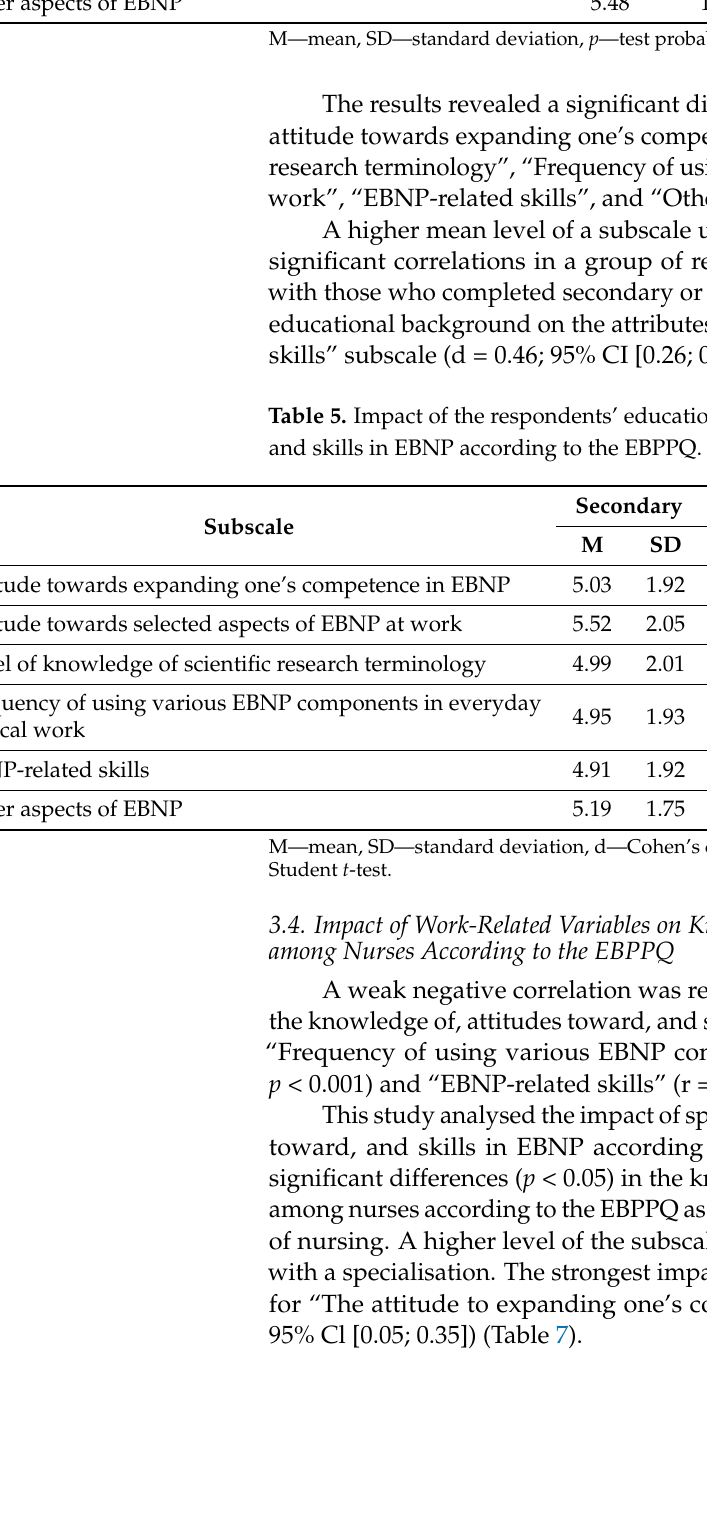
Table 4. Impact of the respondents’ marital status on the knowledge of, attitudes toward, and skills in EBNP according to the EBPPQ. Subscale